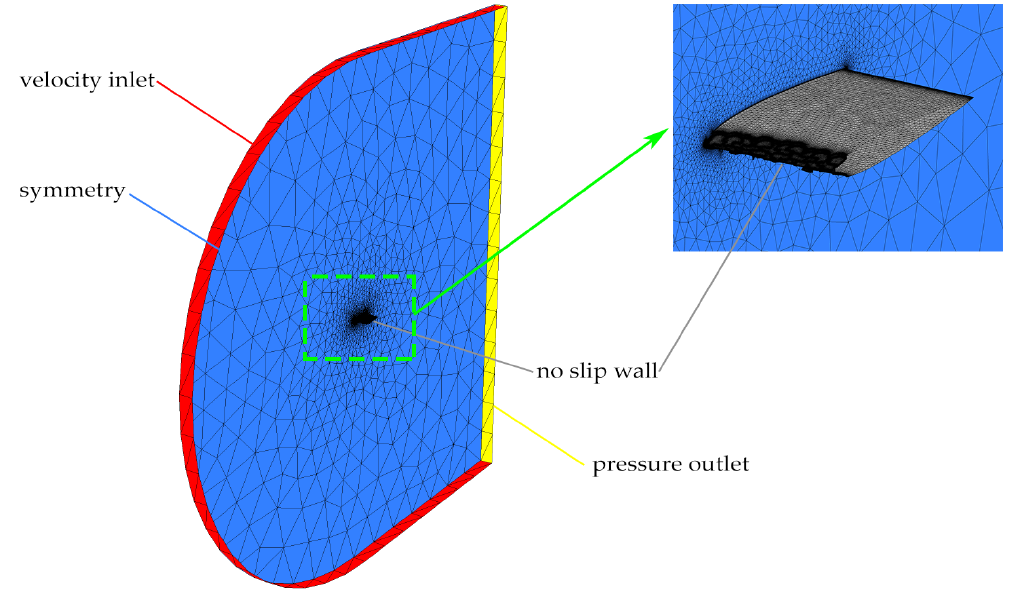
Figure 4. Boundary conditions overview: the red surface is the velocity-inlet while the pressure- outlet is highlighted in yellow. To enhance clarity only one side boundary, with symmetry condition imposed, is shown in light